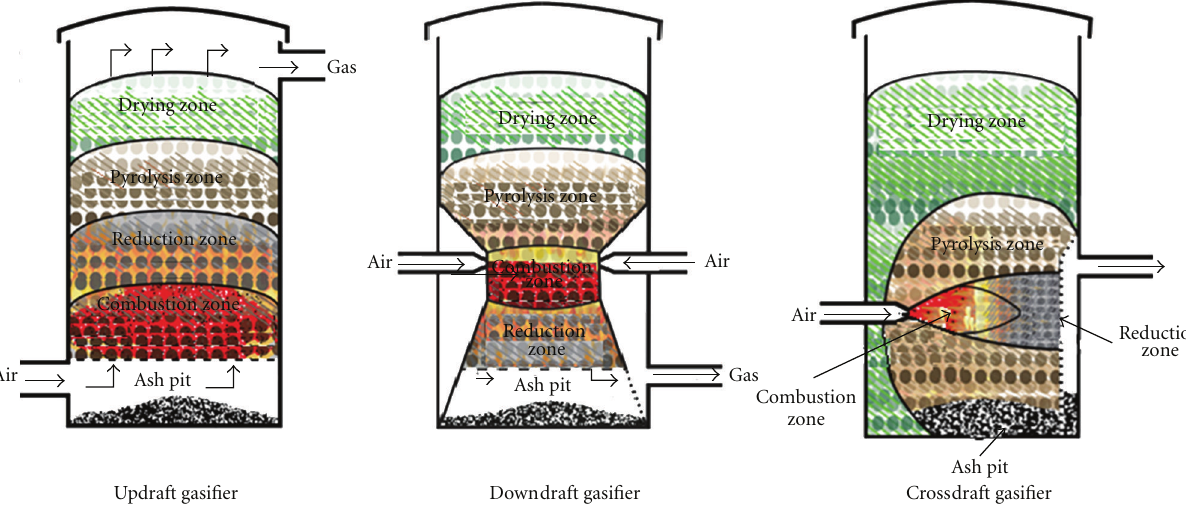
Figure 2: Di ff erent zones of gasification depending upon the types of gasifier. Image source: http://gekgasifier.com/gasification-basics/gasi-